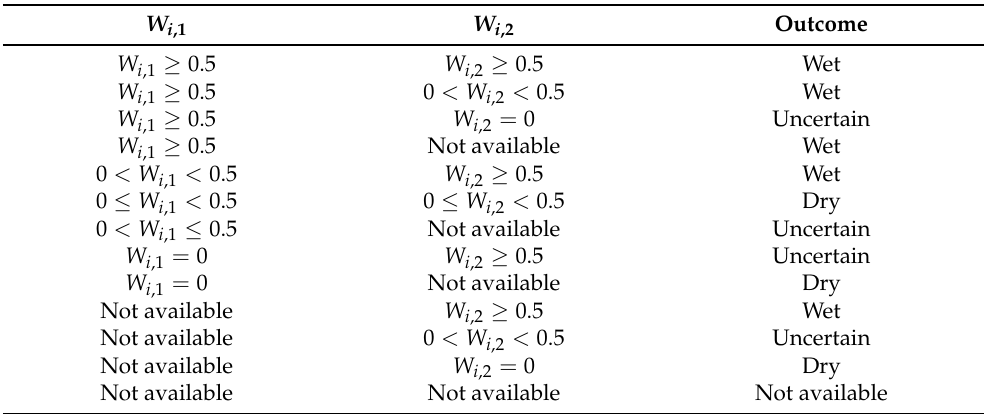
Table 2. Rules for classification of 15 min time slots into dry and wet according to the values of the indicator in